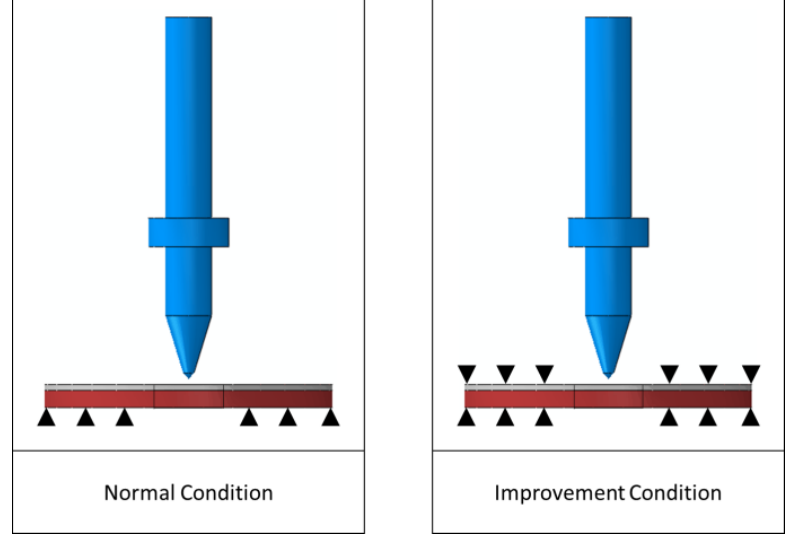
Figure 9. Numerical setup for finite element analysis.